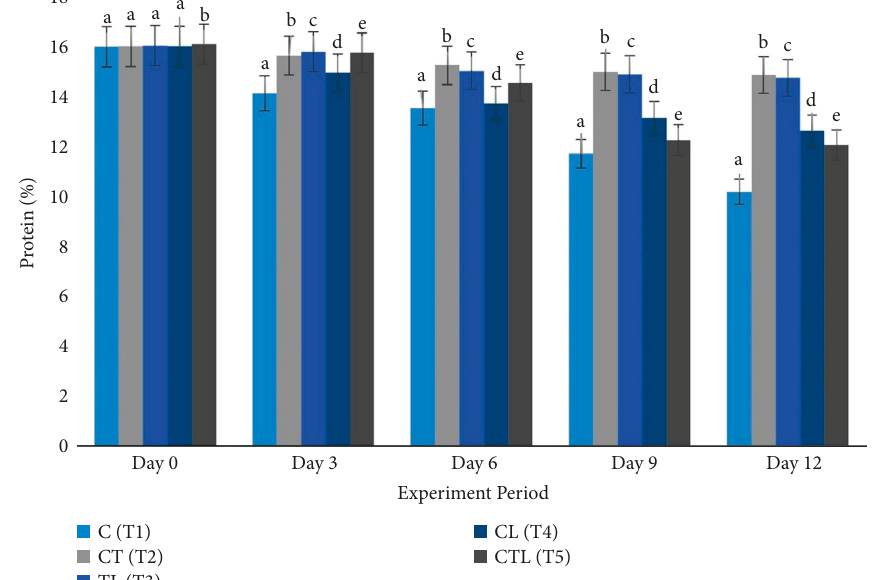
Figure 4: Percentage of protein content in the carp fillet immersed in mixed different extracts of turmeric, cinnamon, and lemon at 4 °